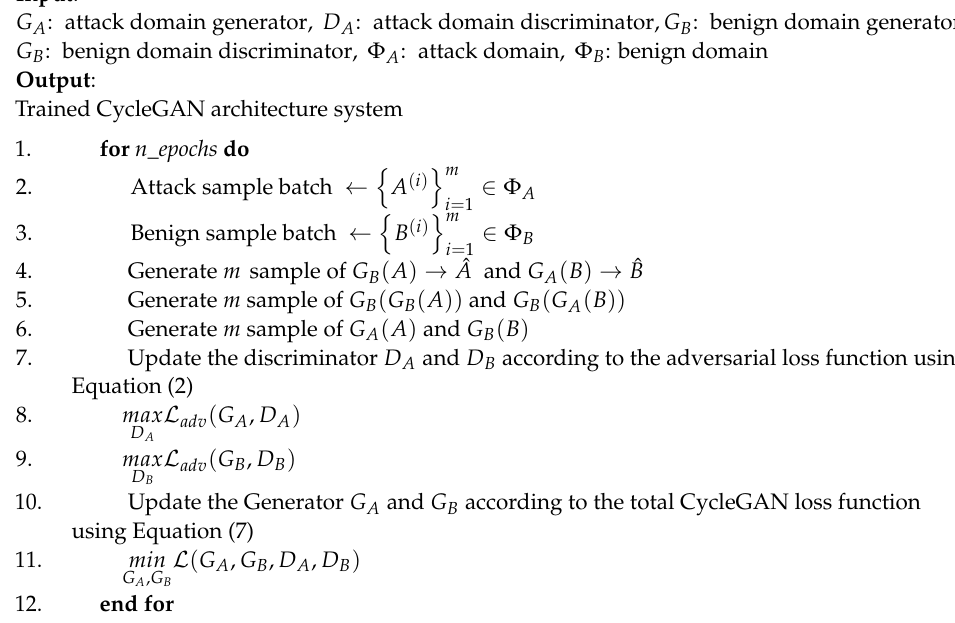
Algorithm 1. Training of the CycleGAN architecture generating system